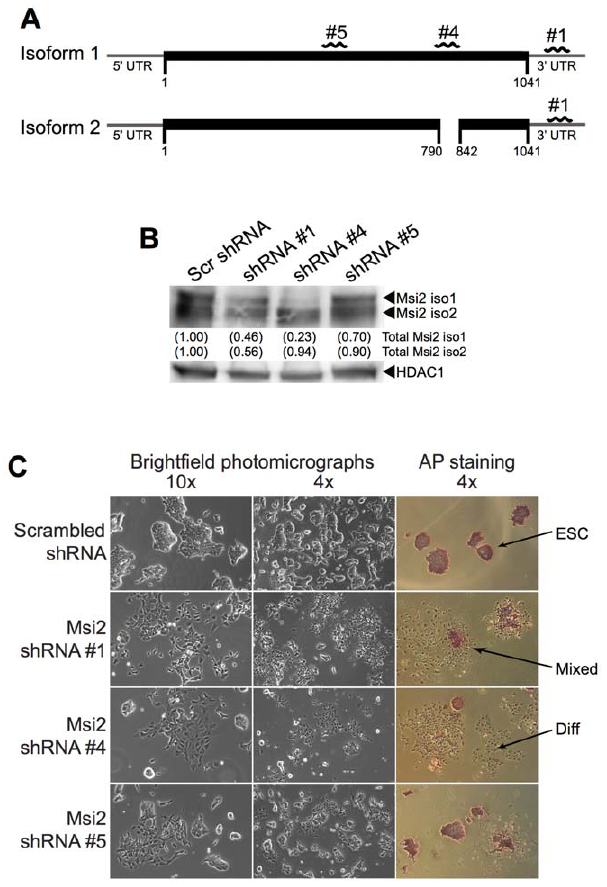
Figure 2. Knockdown of Msi2 results in the differentiation of ESC. ( A ) Regions of Msi2 mRNA targeted by shRNA # 1, shRNA # 4, and shRNA # 5. ( B ) The D3 ESC were infected with lentiviruses that express scrambled (Scr) shRNA, shRNA # 1, shRNA # 4, or shRNA # 5 sequences. Two days after infection, the cells were subjected to puromycin selection for 24 hours. After selection, the cells were subcultured and grown for an additional 24 hours before nuclear extracts were harvested for western blot analysis. HDAC1 was used as the loading control for quantification. ( C ) Bright field photomicrographs of cells subcultured at 5,000 cells per cm 2 were taken 7 days post-infection with each shRNA (left columns). Cells were stained with alkaline phosphatase (right column) 10 days post-infection after being subcultured at 200 cells per cm 2 . Arrows point to colonies that exhibit a morphology characteristic of ESC (ESC), a morphology consisting of ESC and differentiated cells (Mixed), or a morphology characteristic of differen- tiated cells (Diff).